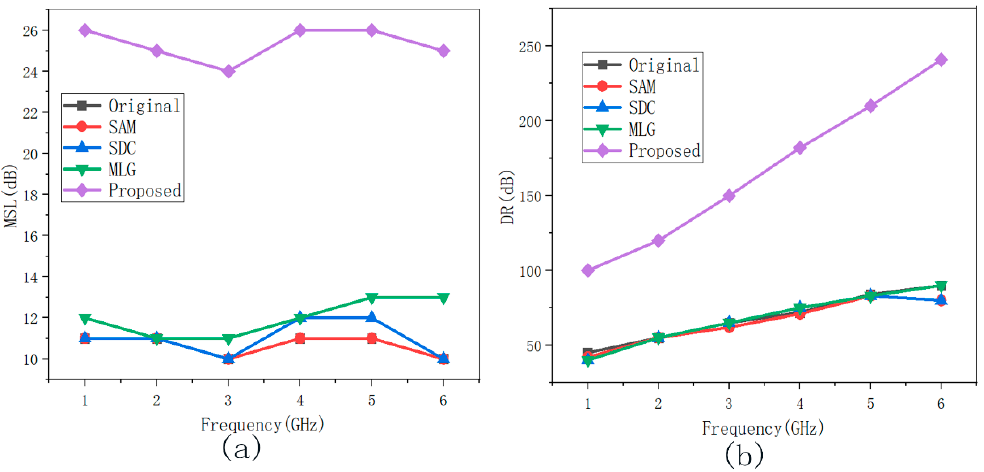
Figure 8. The MSL/DR results for two interference sources in Figure 6 at 1–6 GHz before and after denoising. ( a ) MSL with different frequencies and ( b ) DR with different frequencies.